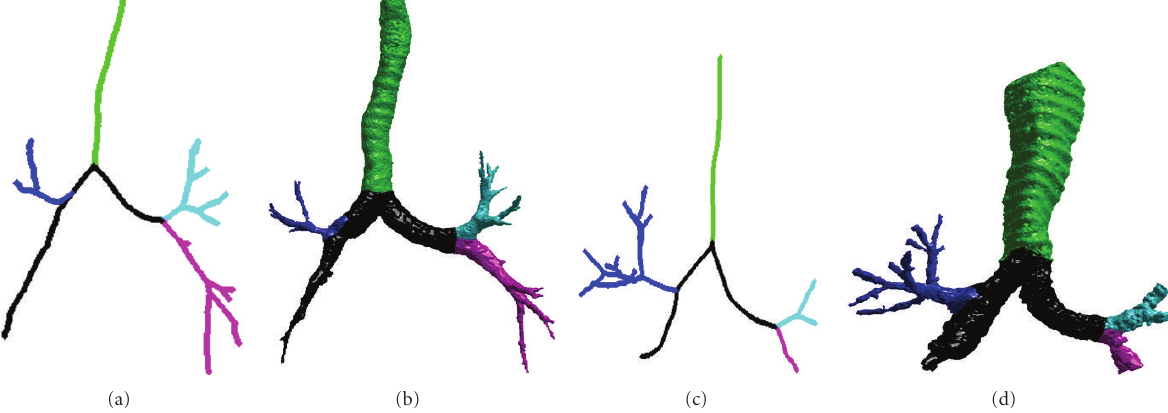
Figure 6: Two failed cases in RML and RLL labeling: (a)-(b) show the skeleton and the labeling result of the first failed example and (c)-(d) show the skeleton and the labeling result of the second failed example.